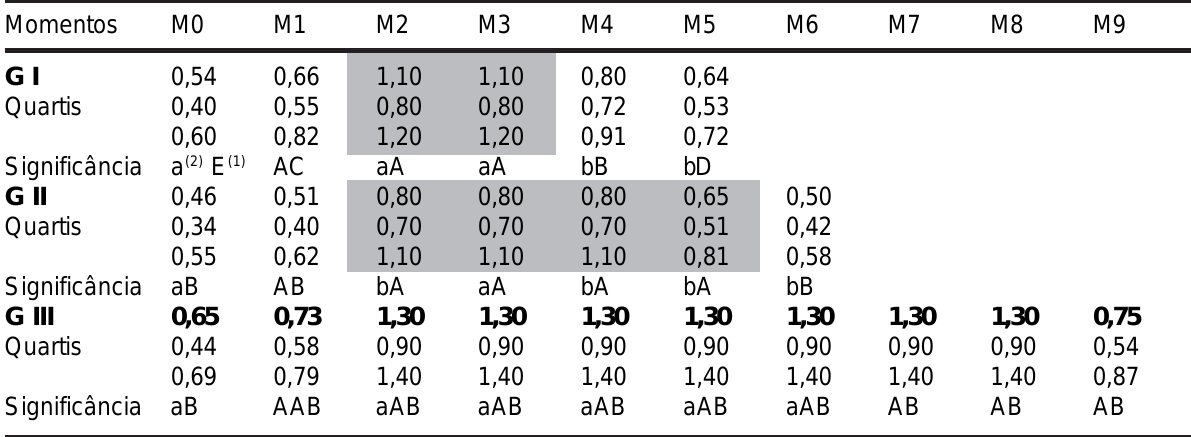
Nota: não se dispõe de dados pois, para os Grupos I e II não foram feitas medidas nestes momentos. (1) - Momentos representados pelas medianas dentro de cada grupo seguidas de mesma letra maiúscula não diferem estatisticamente (p>0,05) (2) - Momentos representados pelas medianas dentro de cada grupo seguidas de mesma letra minúscula não diferem estatisticamente (p>0,05) Válido para todas as tabelas.